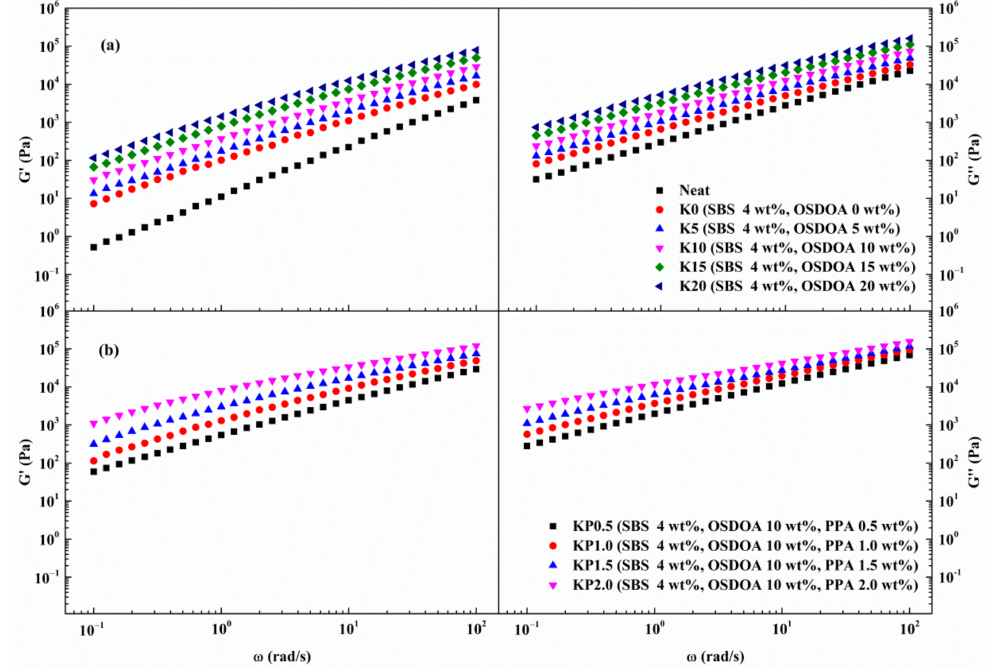
Figure 2. Variations in G (cid:48) and G” with frequency: ( a ) SBS/OSDOA-modified asphalts; ( b ) composite modified